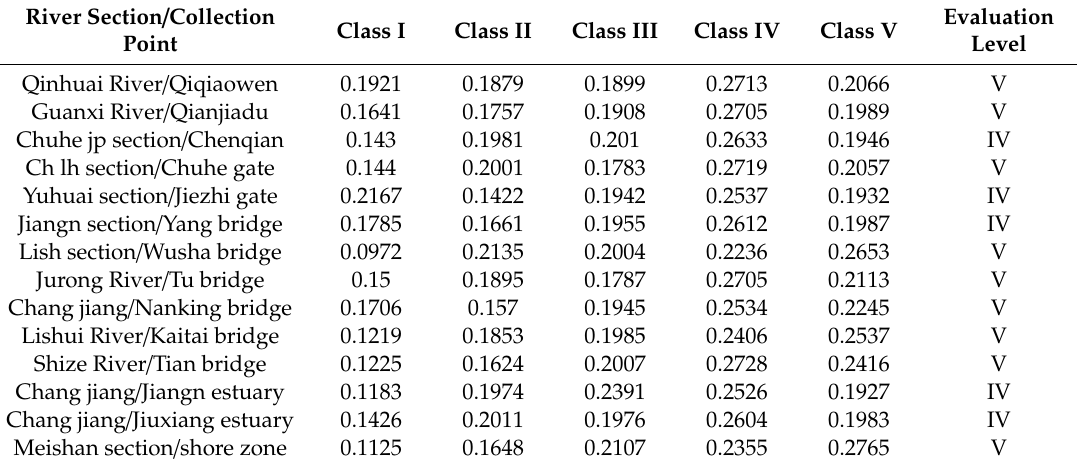
Table 4. Result of the IVFSPA